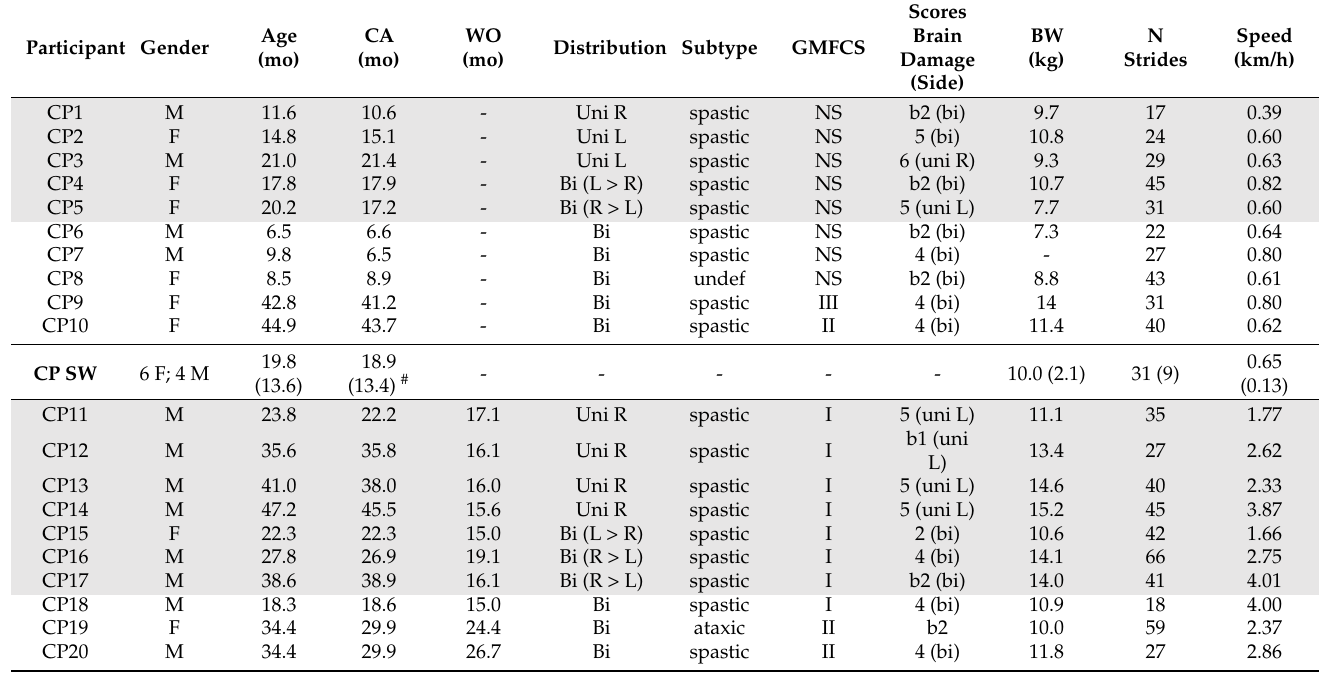
Table 2. Participant